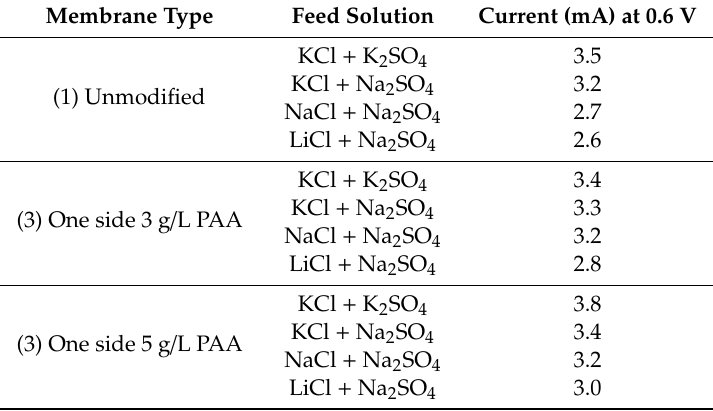
Table 4. Currents obtained at the maximum applied voltage of 0.6 V as a function of the feed composition and the type of membrane. Receiver solution: 0.5 M NaCl.